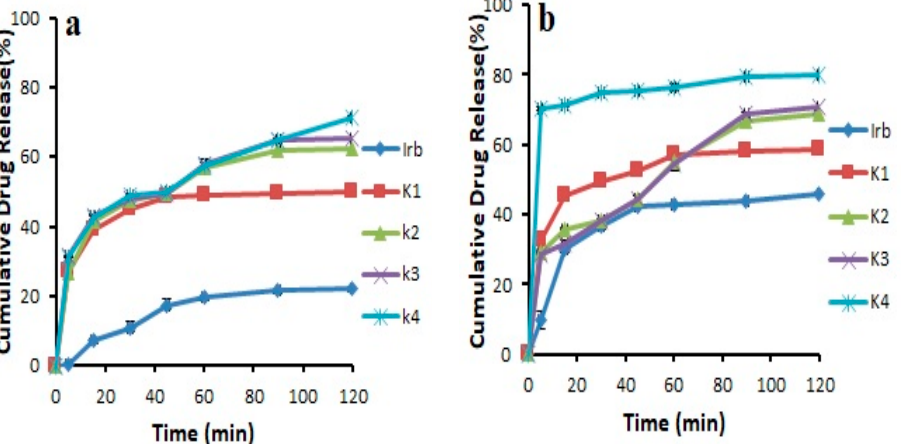
Figure 5. Dissolution profile of pure Irbesartan and binary solid dispersions prepared with Kollidon ® VA 64 in ( a ) pH 6.8 phosphate buffer ( b ) 0.1 N HCl (n = 3, mean ± SD).